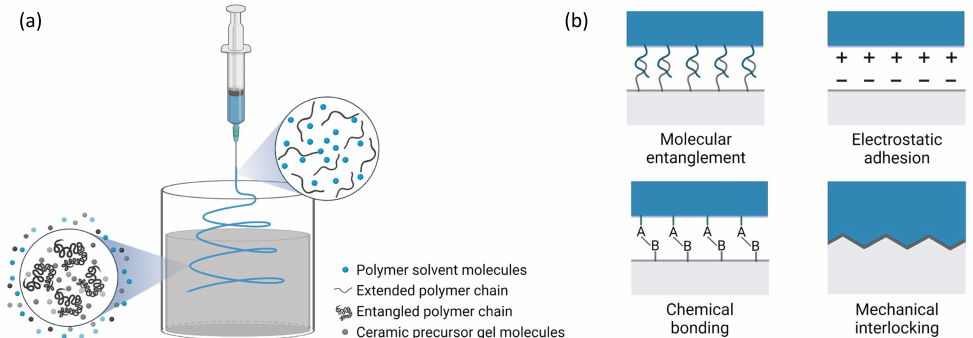
Figure 12. ( a ) The schematic of interactions between the electrospinning polymer solution and the ceramic precursor gel. ( b ) Possible fiber-matrix interfacial bonding mechanisms in the hard- ened